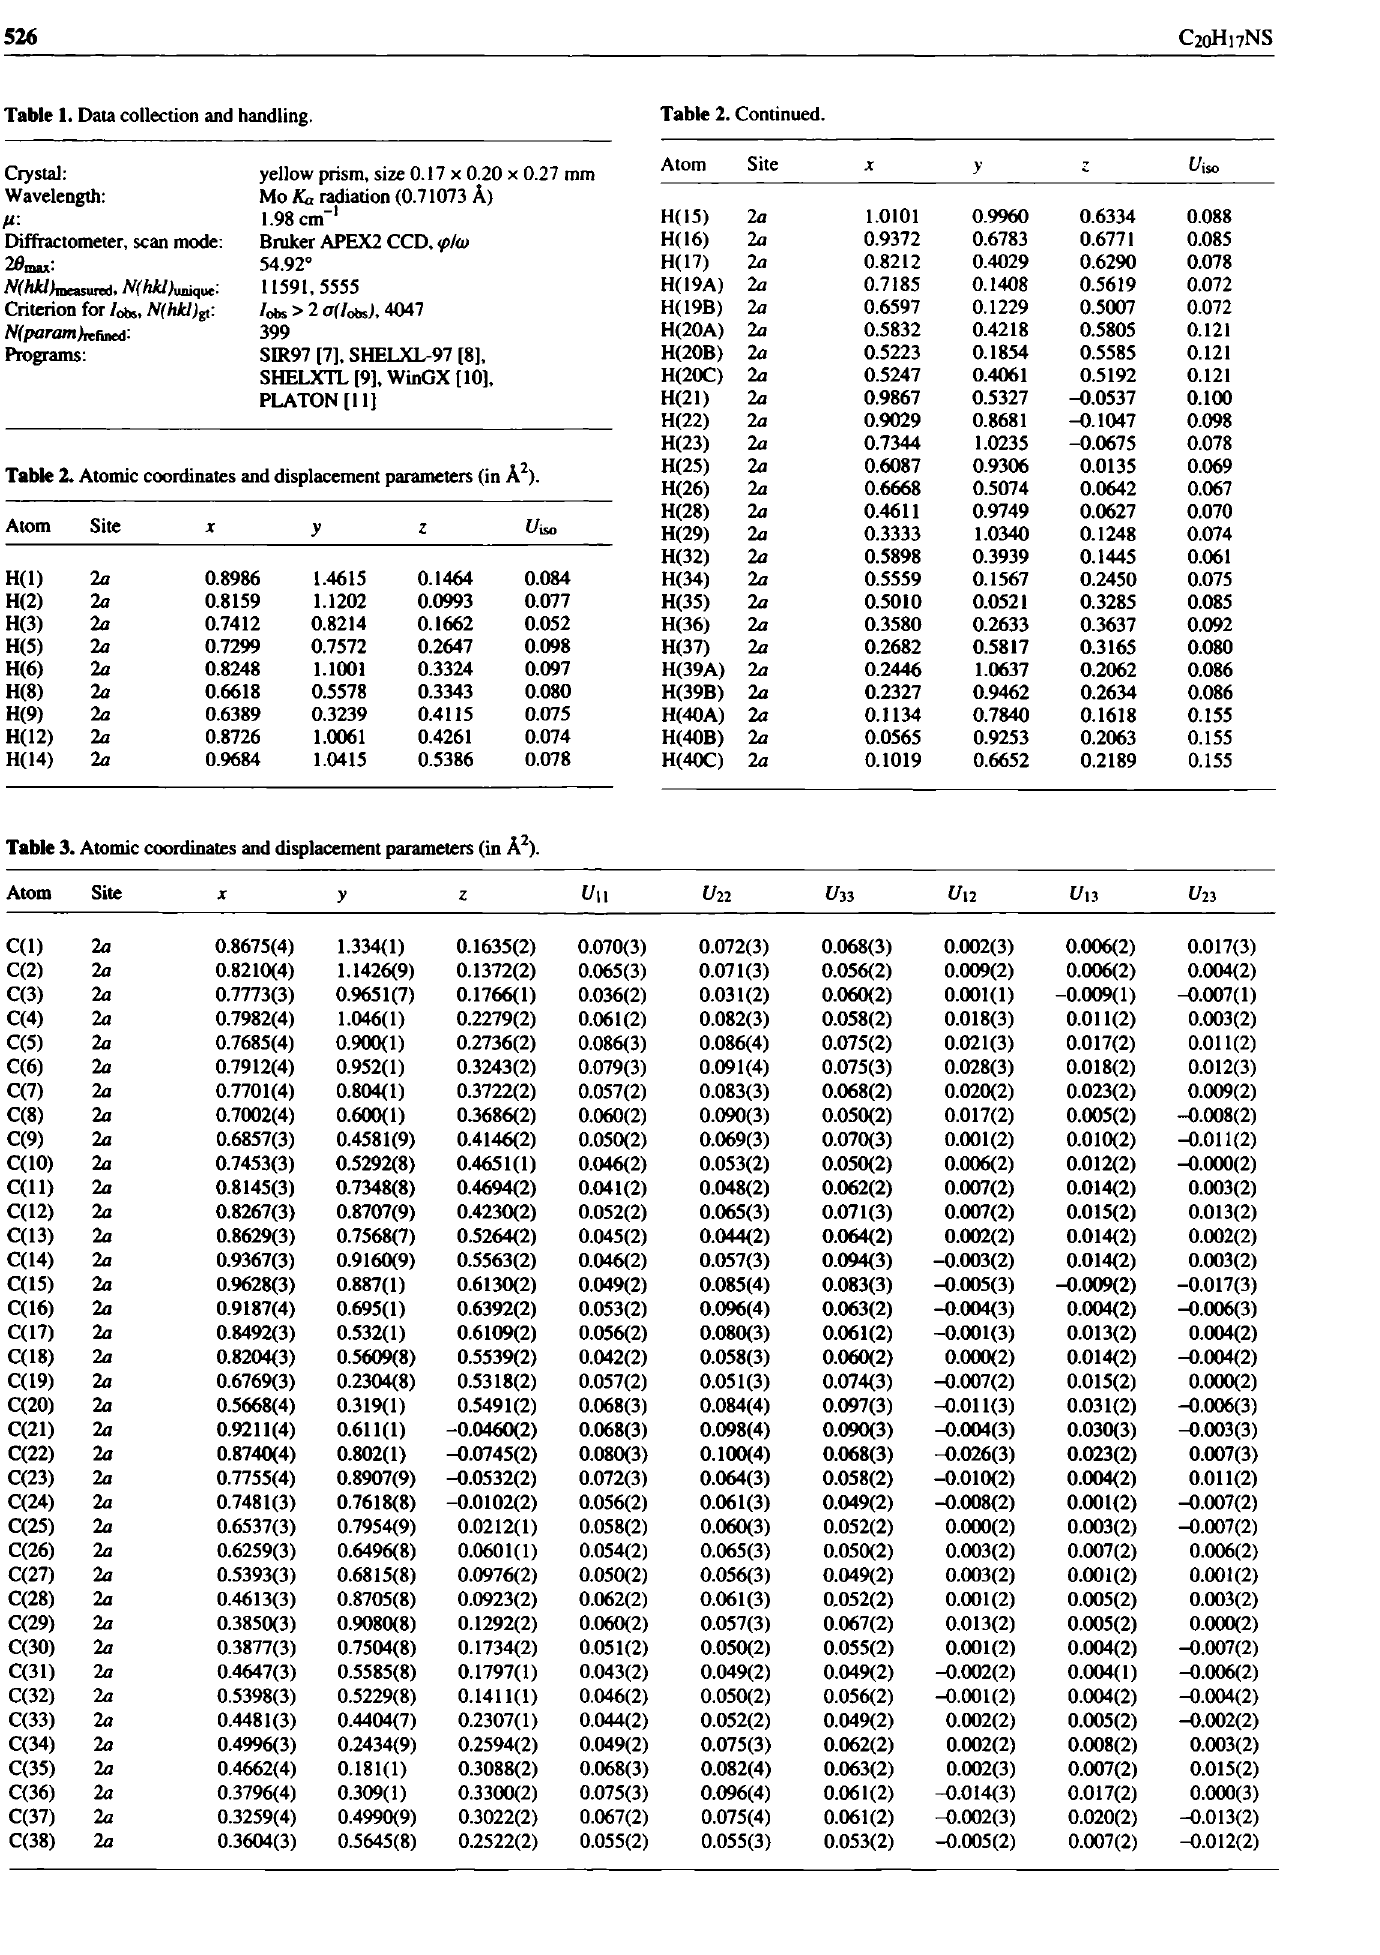
Table 1. Data collection and handling.